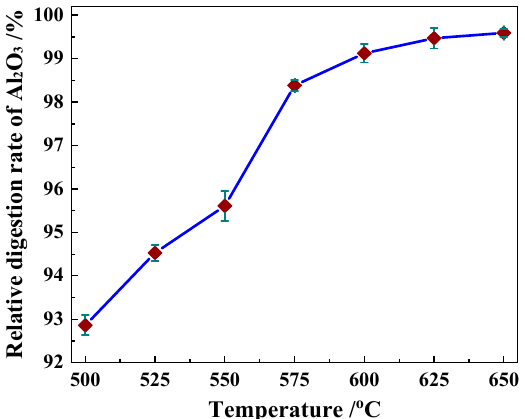
Figure 13. Relative dissolution rate of alumina in roasted high-sulfur bauxite.